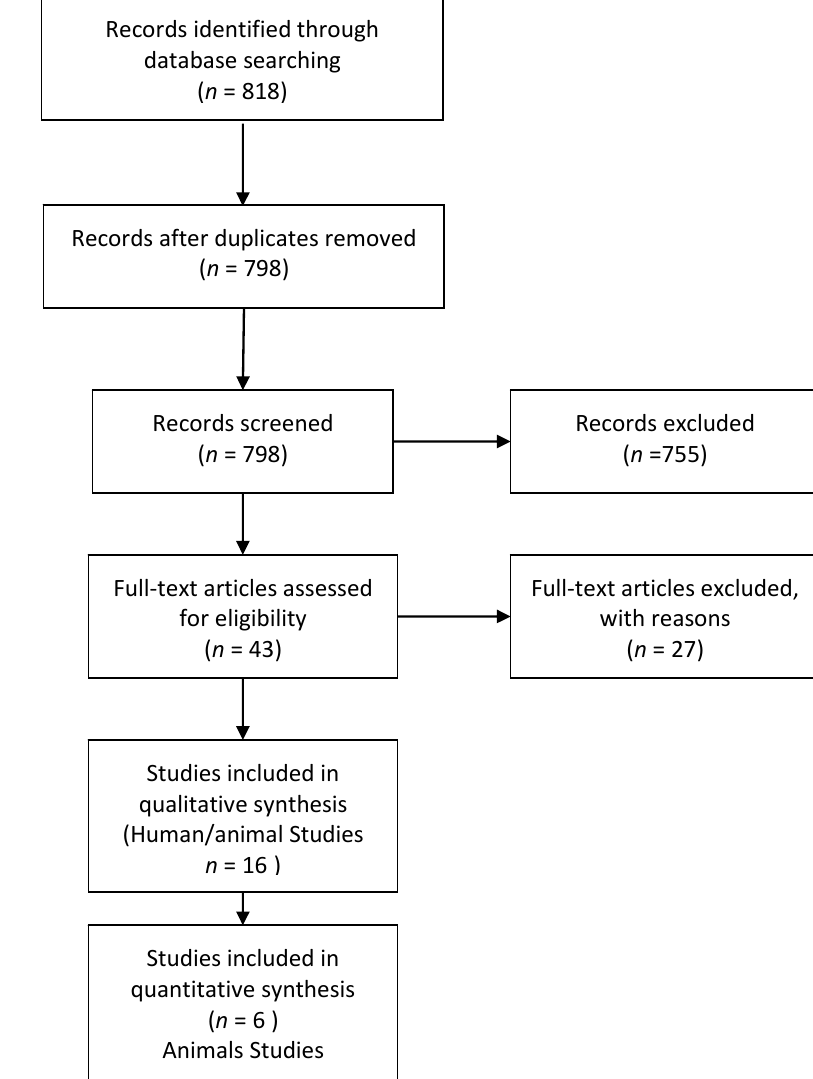
Figure 1. Studies screening and inclusion for qualitative analysis and meta-data evaluation processes [63].